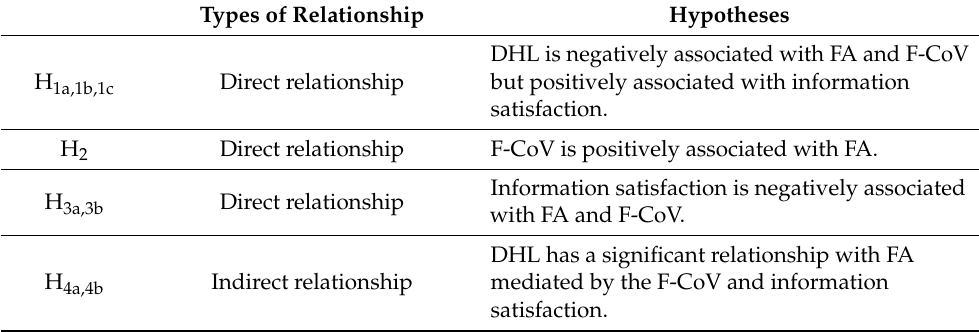
Table 1. List of research